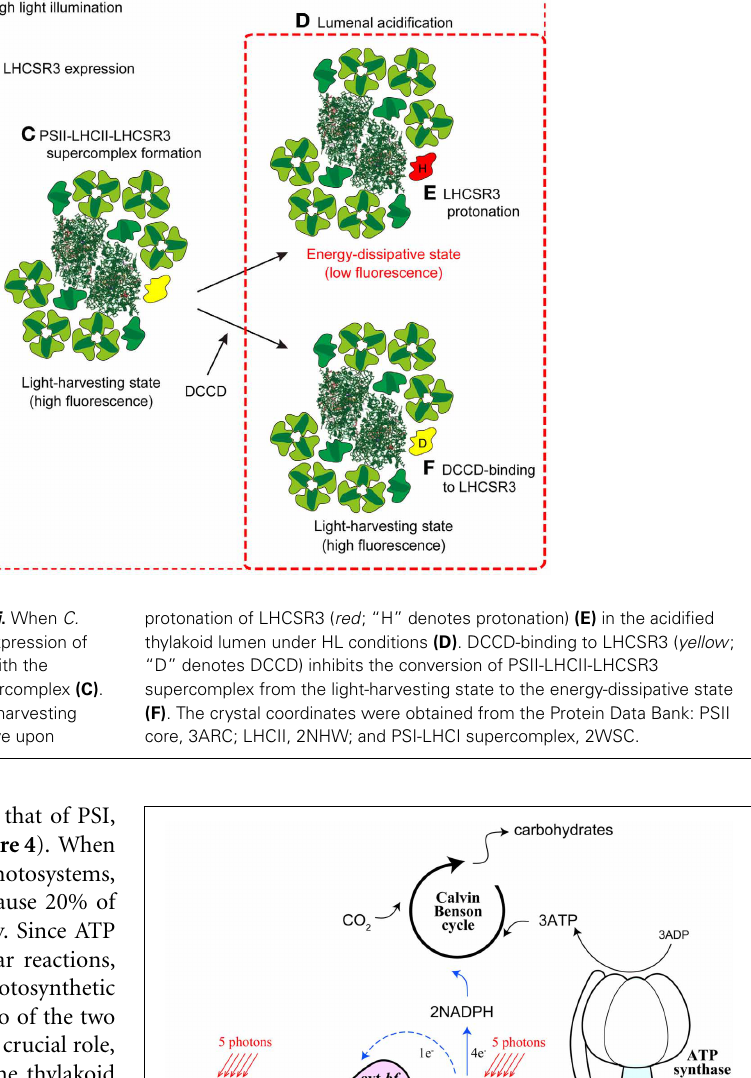
FIGURE 4 | Schematic representation of the movement of protons and electrons by the photosynthetic electron transport chain in the chloroplast. Pathways and stoichiometry of light-driven electron transport, proton translocation, and ATP synthesis on the thylakoid membranes are shown. Thick arrows represent the pathways of protons, blue solid and blue dashed arrows represent LEF and CEF, respectively.